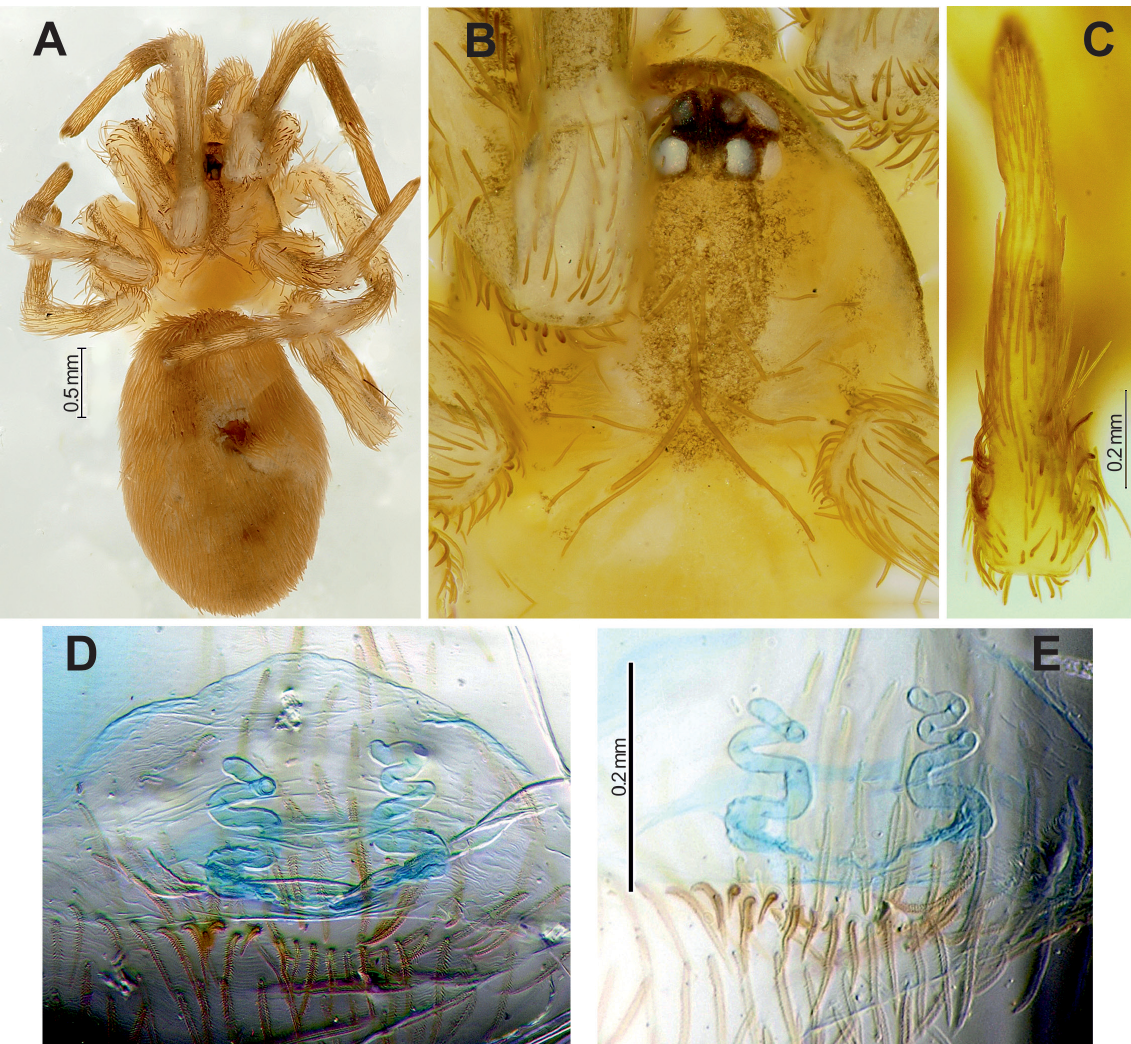
Fig. 18. Somatic characters and endogyne of Zaitunia persica Brignoli, 1982, holotype, ♀. A . Habitus, dorsal. B . Prosoma, dorsal. C . Metatarsus and tarsus iV, dorsal. D–E . endogyne, dorsal. Scale bars: a = 0.5 mm; C, e = 0.2